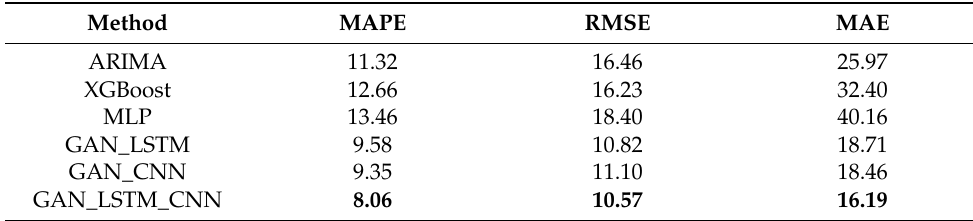
Table 5. Performance Comparison Jiedaokou Area.